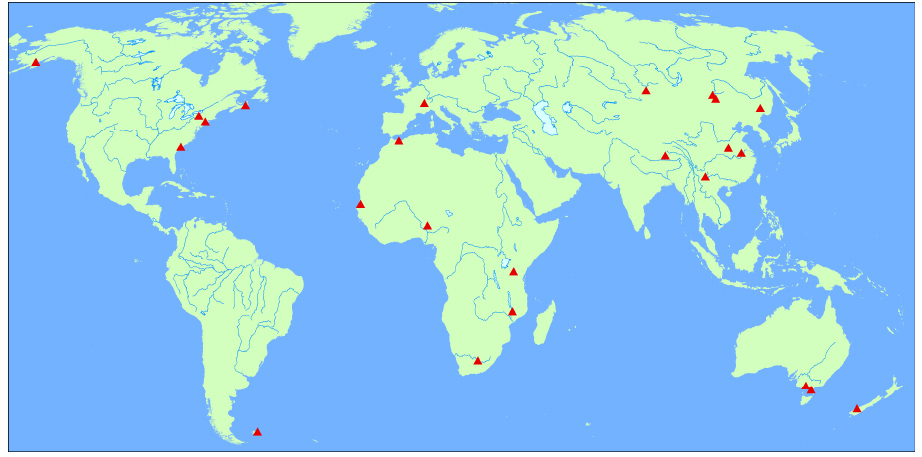
Figure 1. Map of the water bodies in the study. R rs were obtained using the ACOLITE atmospheric correction processor, which is designed for use in coastal and inland water applications. ACOLITE employs the ‘dark spectrum fitting’ approach, which automatically selects the most relevant spectral band and aerosol model [19–22]. ACOLITE supports Landsat-8. It can mask all non-water pixels in an image and calculate R rs of all water pixels. Note that many of the known AC methods (such as iCOR, FLAASH, and 6S) were not compared in this study as they are not specifically developed for water applications and their results are only slightly different. After applying the ACOLITE correction, we selected the WOI pixels in the resulting image and calculated their R rs_norm and thus the SPD . The maximum 2% and minimum 2% R rs within the WOI pixels were excluded from the SPD calculations, and the remaining 96% were used to construct the SPD ’s histograms with bin number = 20 [1]; see SPD examples in Figure 2. As the number of WOI pixels in each water body varied, we calculated the pixel probability (the percentage of WOI pixels in each bin) rather than the raw pixel